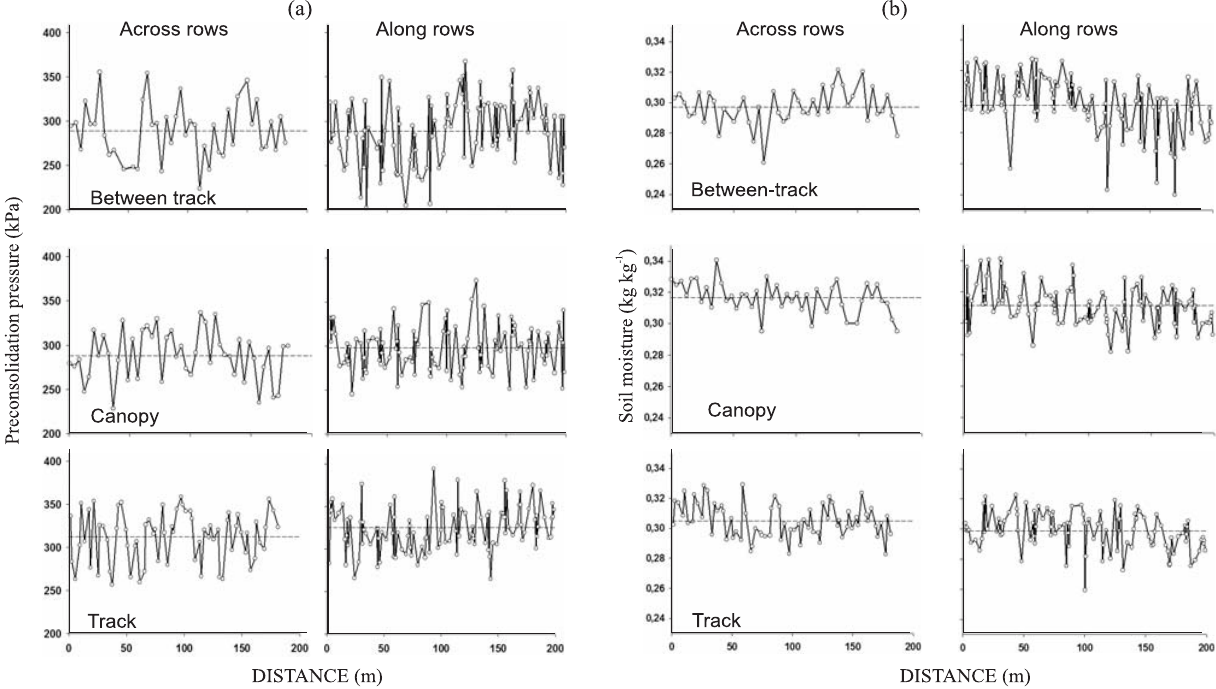
Figure 2. Spatial distribution of preconsolidation pressure (a) and soil moisture (b) at three points in a coffee plantation in 200 m transects across and along the direction of coffee rows. Table 2. Descriptive statistics for preconsolidation pressure ( σσσσσ across and along